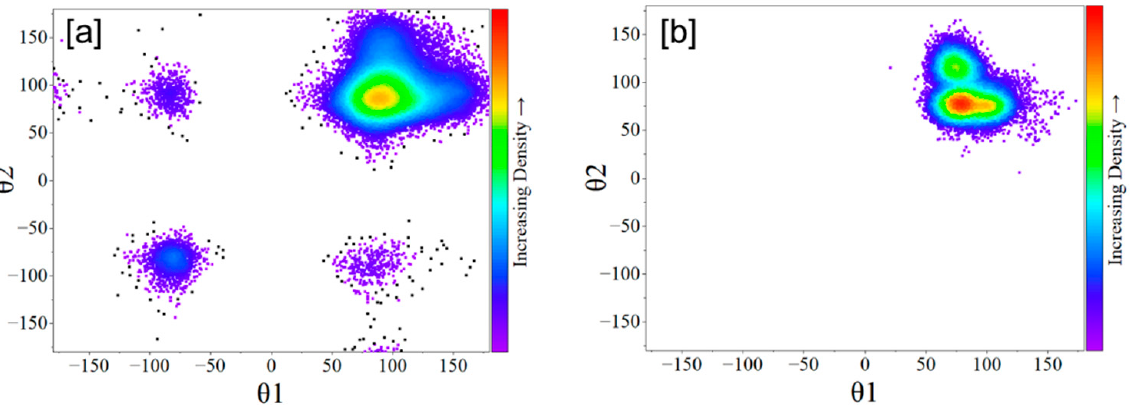
Figure 11. The θ 1 - θ 2 map of the t -HOPO 4 − ( a ) and U- t -HOPO complex ( b ) obtained from the 100 ns MD simulations.